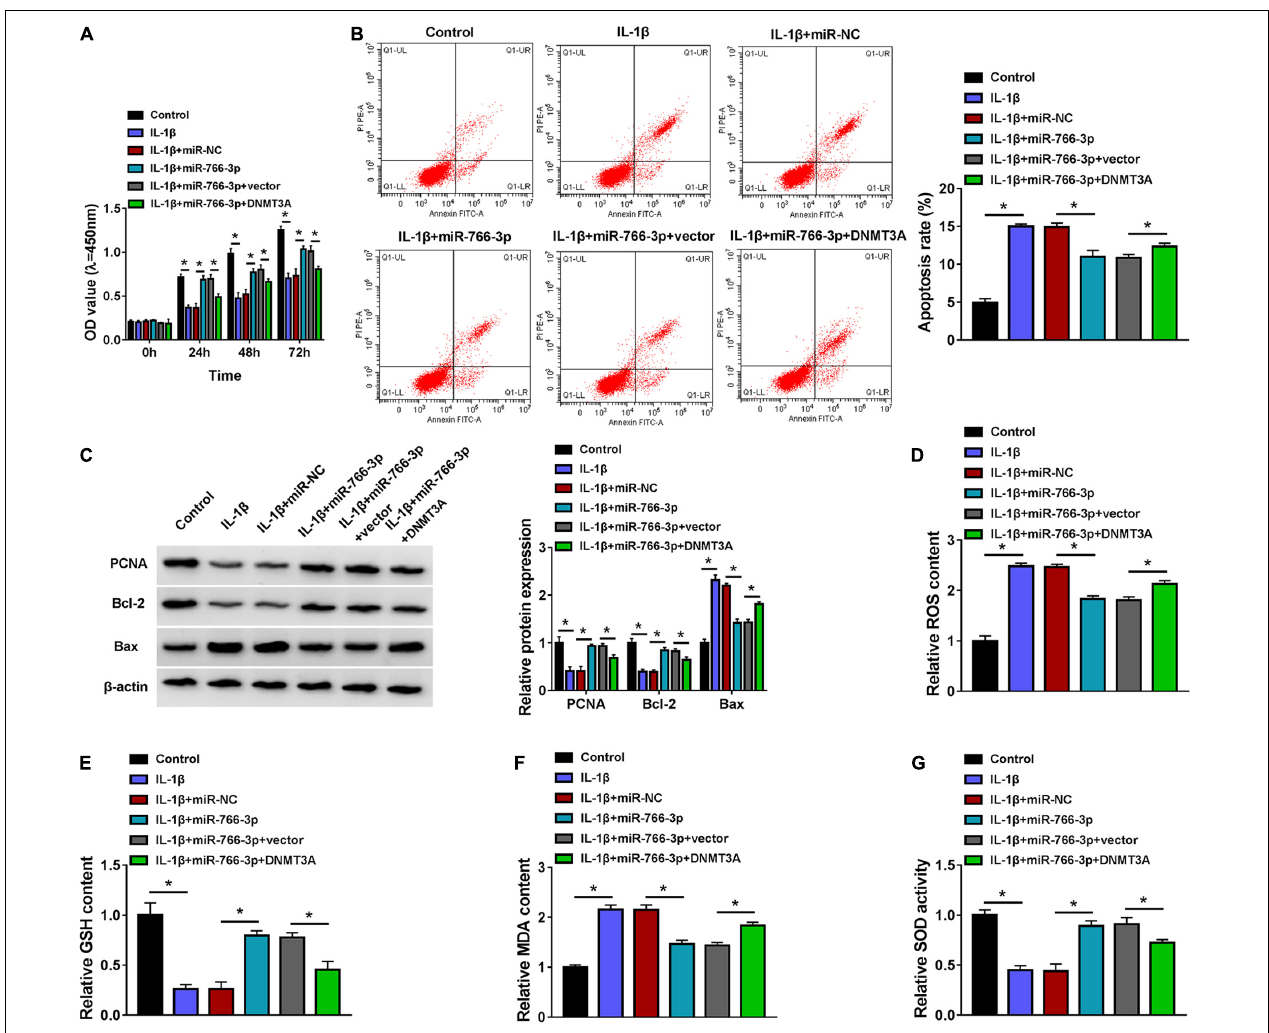
FIGURE 7 | Restoring miR-766-3p attenuated IL-1 β -induced oxidative injury in chondrocytes, and this effect was abrogated by DNMT3A upregulation. CHON-001 cells were transfected with miR-766-3p/NC or miR-766-3p combined with DNMT3A or vector prior to treatment of IL-1 β (10 ng/ml) for 24 h. (A) CCK-8 monitored the OD values of inoculated cells during 72 h. (B) FCM tested the apoptosis rate (%). (C) Western blotting examined the relative protein expression of PCNA, Bcl-2, and Bax. (D–G) Special assay kits determined the levels of ROS, GSH, MDA, and SOD. * P < 0.05 was determined by ordinary one-way ANOVA or two-way